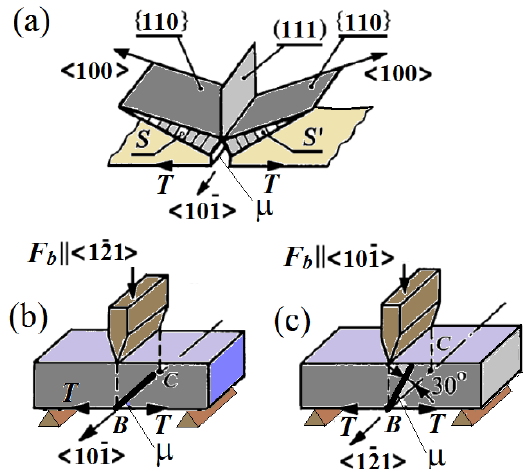
Figure 11. Scheme of the formation of a microcrack µ during bending of Bi–Sb single crystals: ( a ) The formation of a microcrack µ along the binary axis <101 > in the region of intersection of twins S and S (cid:48) . ( b , c ) The location of the microcrack µ in the ABCD plane near the line of maximum tensile stresses at F b || <121> and F b || <101>, respectively.